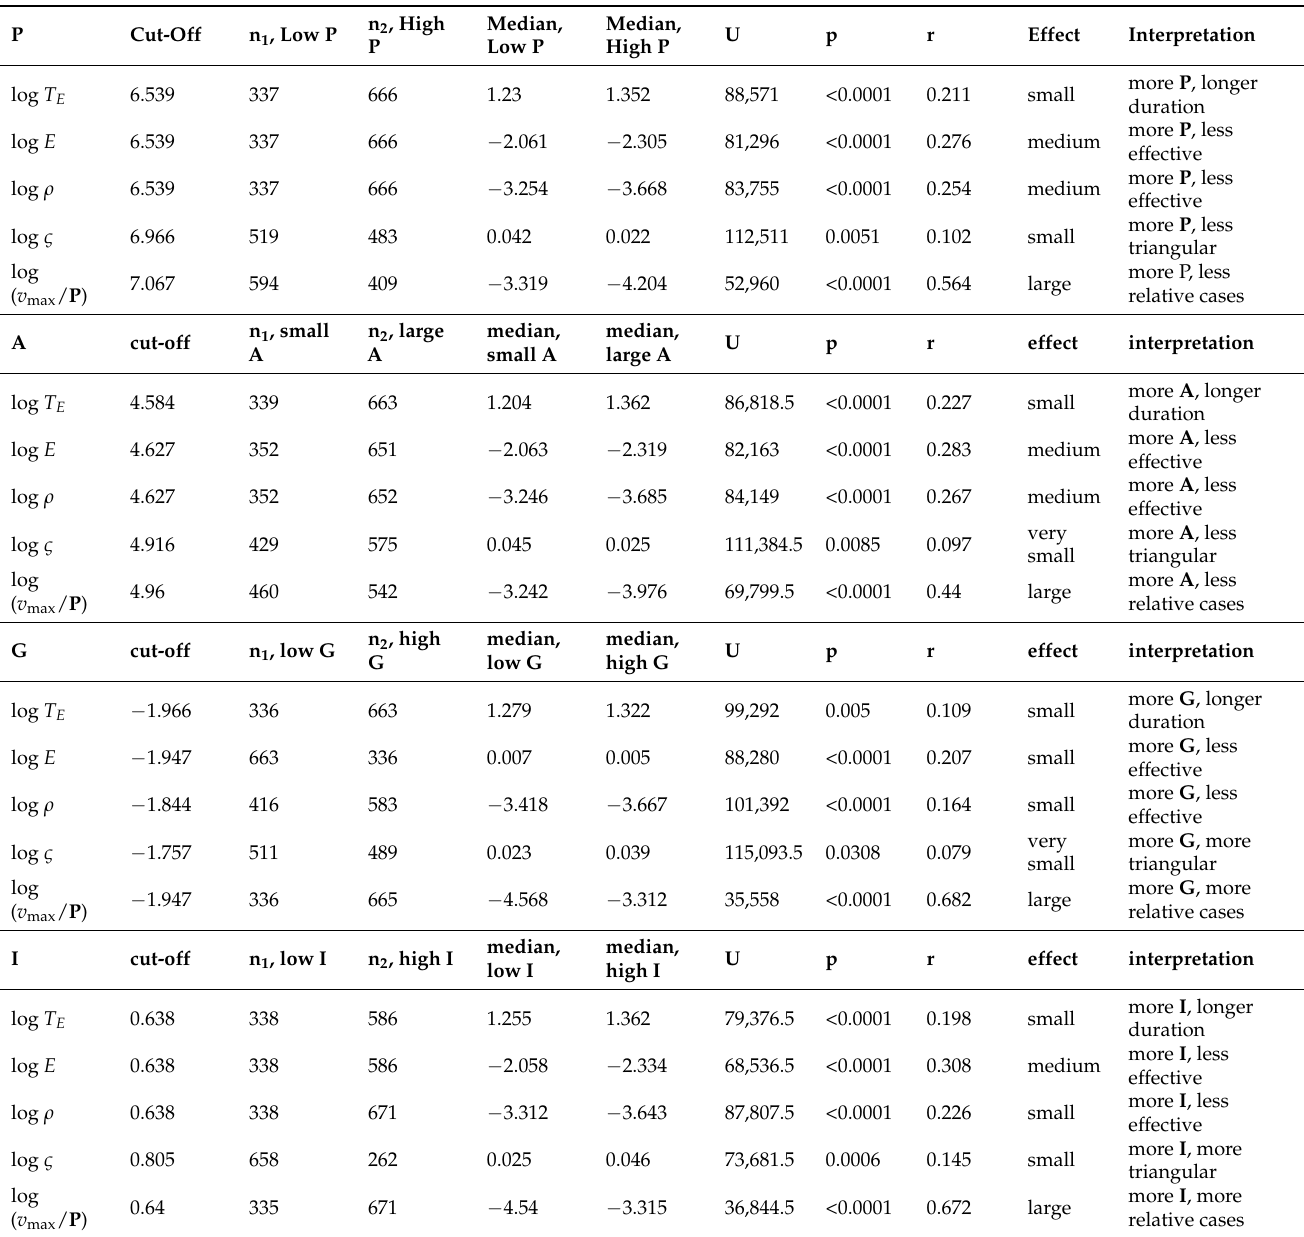
Table 3. Relationship between epidemiological parameters and geographical and socioeconomic data across all 1000 waves ; P = population; A = land area; G = GDP per capita (GDP/ P ); I = educa- tional index; D = population density ( P / A ); T E = duration of the effective phase; E = effectiveness; ρ = E / T E and log ς = wave shape factor; v max = peak velocity; v max / P = peak velocity per population P ; cut-off = value of P , A , G , I , or D that divides, e.g., P into two subsamples of low and high P with associated, e.g., E -values that are significantly different at the lowest possible p-value (cf. Figure 3c,d); n 1,2 = sample sizes for the Mann–Whitney U test; U = U-statistic value of the Mann–Whitney test; p = probability value; r = effect